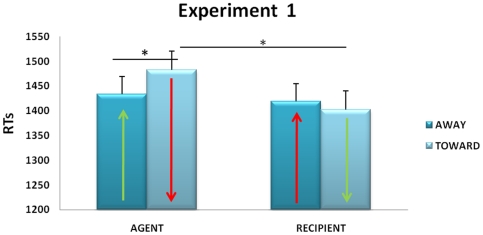
Mean Response Time values for the French version of the ACE paradigm, as revealed by Experiment 1.The arrows indicate response movement direction. The green arrows correspond to the compatible conditions, agent-away and recipient-toward. The red arrows correspond to the incompatible conditions.